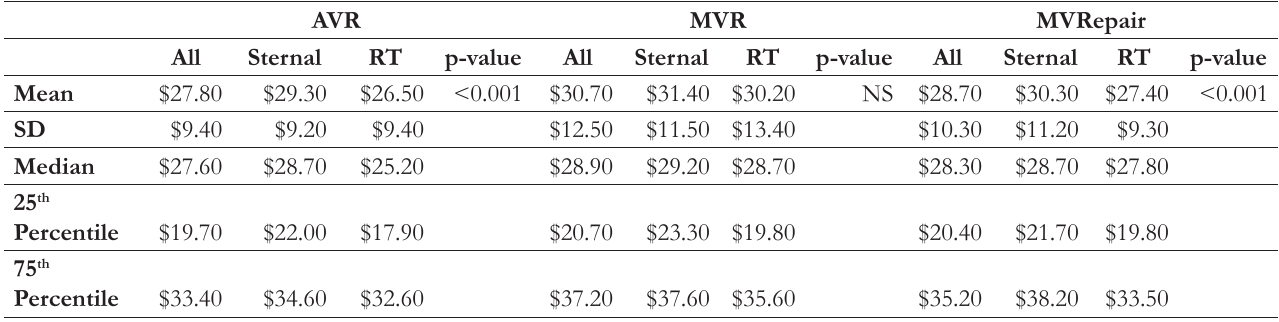
Table 2. OR Costs per Minute After Matching by Valvular Procedure AVR MVR MVRepair All Sternal RT p-value All Sternal Mean